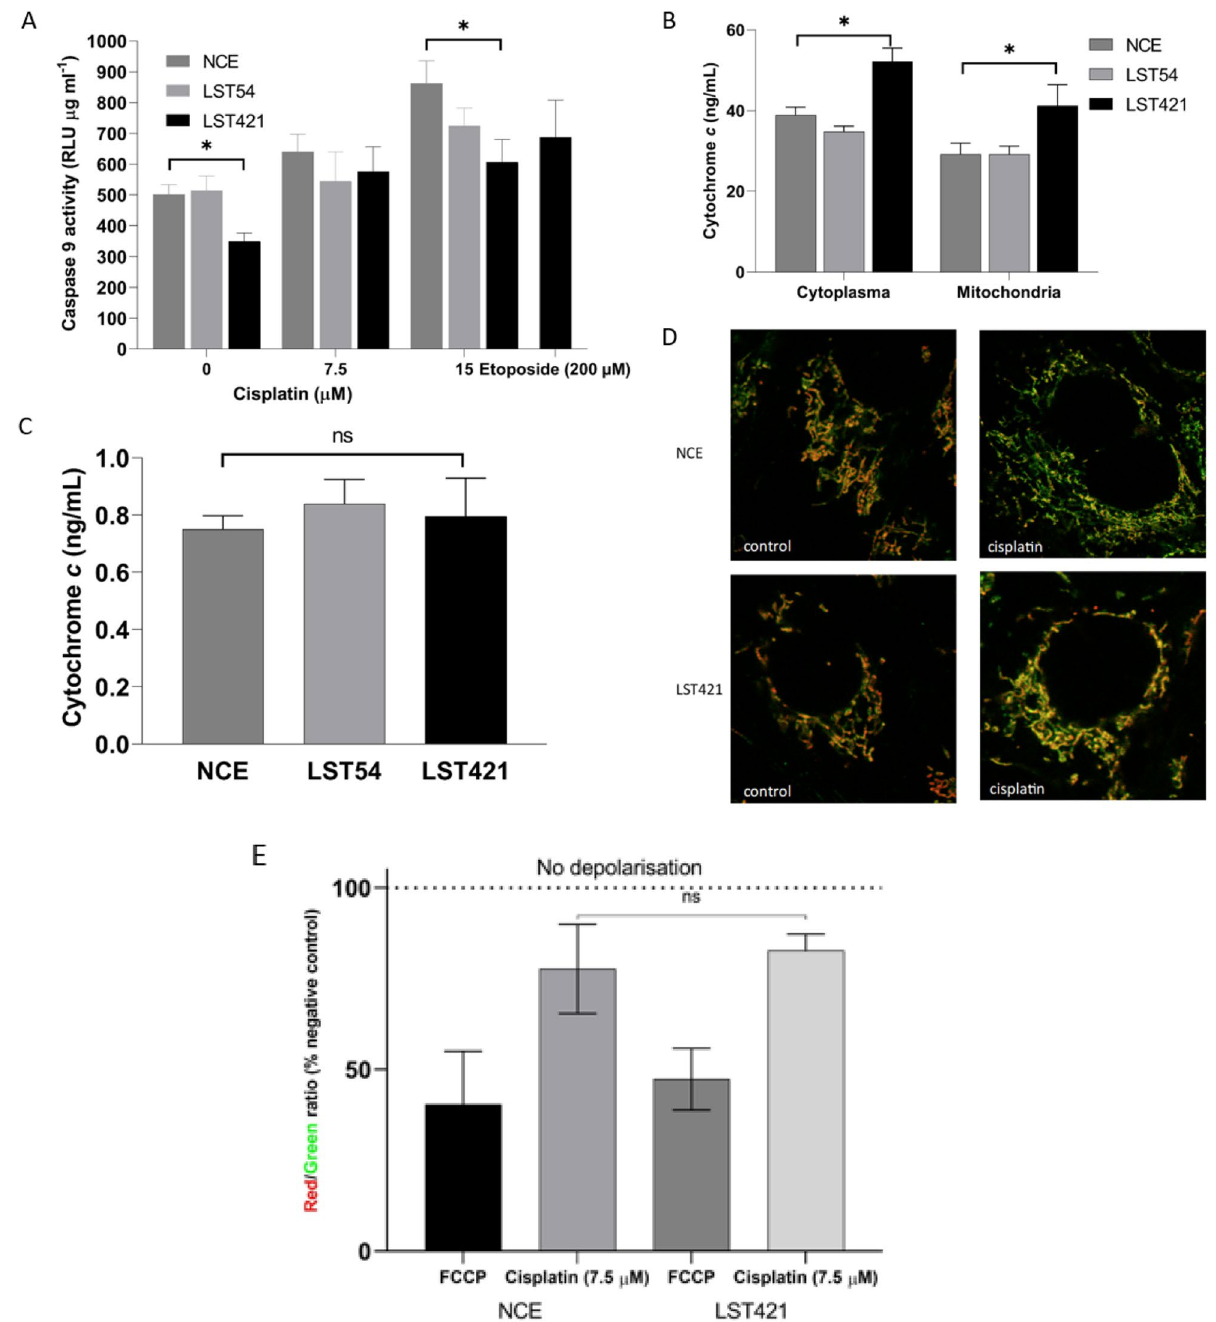
Figure 6. ( A ) Caspase 9 release from NCE control, LST54 and LST421 cells as measured through Caspase-Glo 9 assay kit over 0, 7.5 and 15 µM cisplatin and the positive control etoposide (200 µM). ( B ) ELISA detection of cytochrome c from both cytoplasmic and mitochondrial fractions in LST421, LST54 and NCE cells after cisplatin exposure (7.5 µM). ( C ) Comparison of the ratio of mitochondrial:cytoplasmic cytochrome c after exposure to cisplatin (7.5 µM). ( D ) Cytochrome c release from mitochondria using Mitotracker green and FITC 568 secondary labelled cytochrome c . ( E ) Mitochondrial depolarisation measured using JC-1 fluorophore in the NCE control and LST421 after exposure to FCCP (20 nM) and cisplatin (7.5 µM). Unpaired t -test used to determine statistical significance. * indicates a p < 0.05. ns =